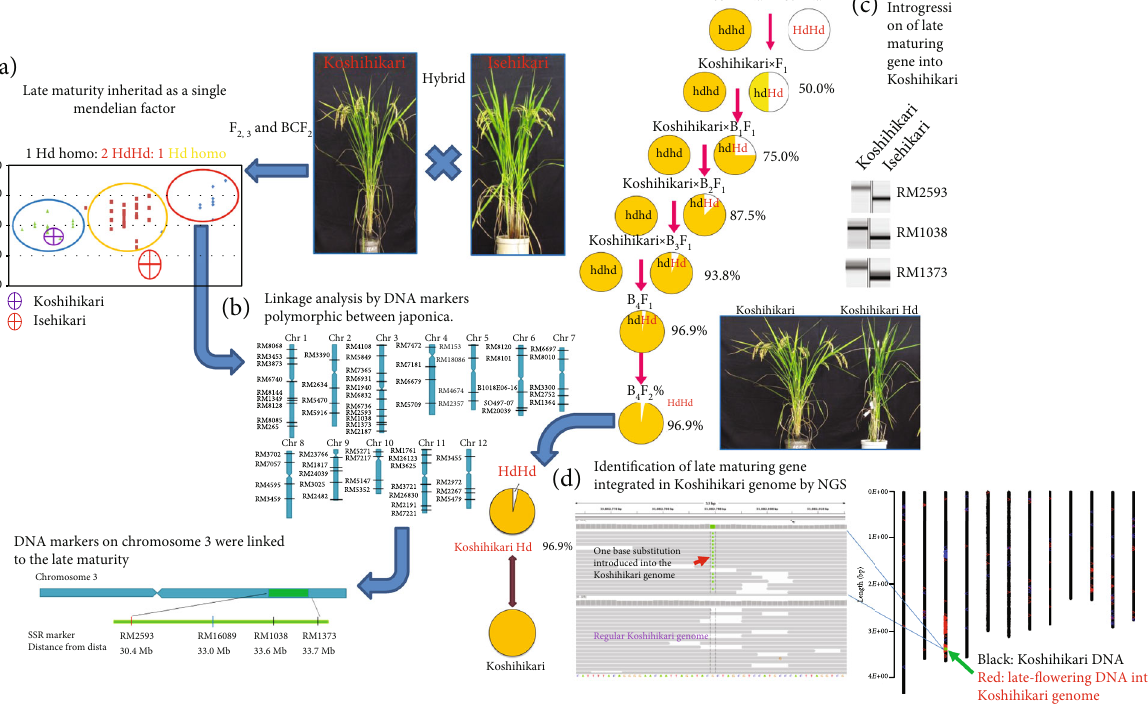
Figure 2: Genetic procedure to identify a candidate SNP for late maturity derived from a cultivar Isehikari. (a) Genetic analyses for late maturity through F and F between Koshihikari × Isehikari and the backcross BC 2 3 line in Koshihikari × Isehikari as a nonrecurrent parent. The late maturity derived from Isehikari was inherited as a single the latest F 3 Mendelian factor. (b) Molecular linkage analysis by using late-maturing homozygous F markers distributed on 12 rice chromosomes. The late-maturing gene was linked to the SSR markers on the long arm of chromosome 3. (c) Development of late-maturity isogenic Koshihikari by continuous backcrossing for NGS analysis. (d) Whole-genome analysis of isogeneic lines (BC F and BC F ) integrated with the late-maturing gene in the Koshihikari 4 2 6 2